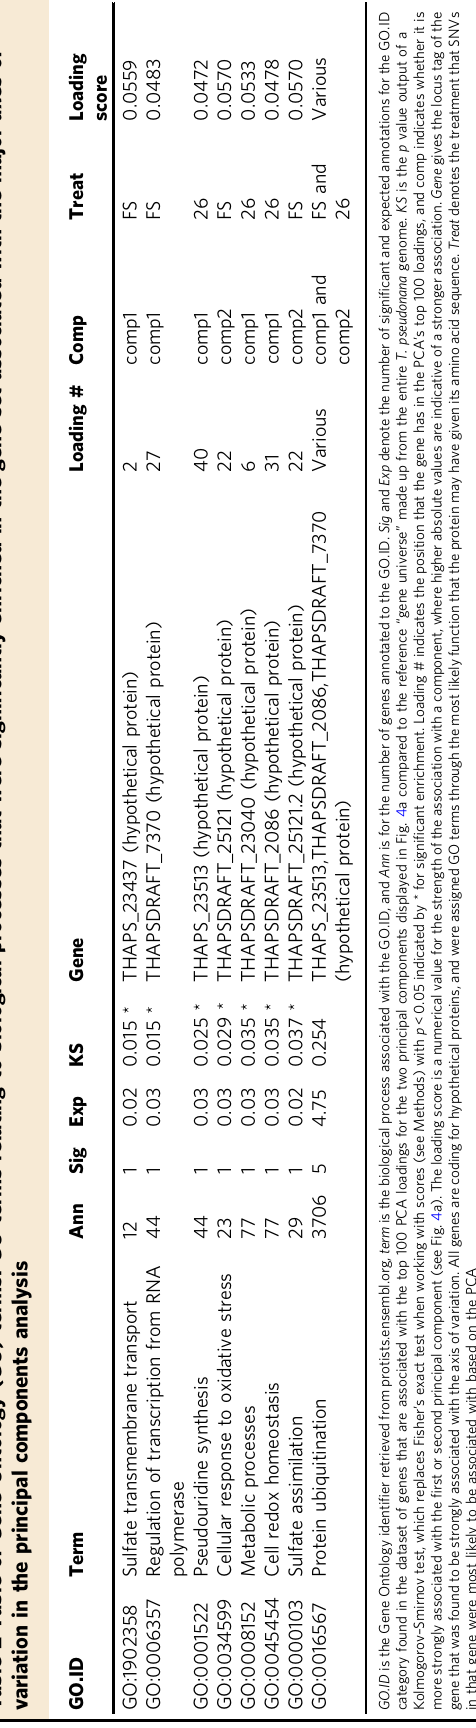
Table 1 Results of the analysis of molecular variance (AMOVA). AMOVA was used to assess genetic divergence within treatments (i.e., among biological replicates in a given treatment) and between treatments (i.e., between the different selection environments) σ 2 % p value 22 °C Within population ( σ 2 WP )